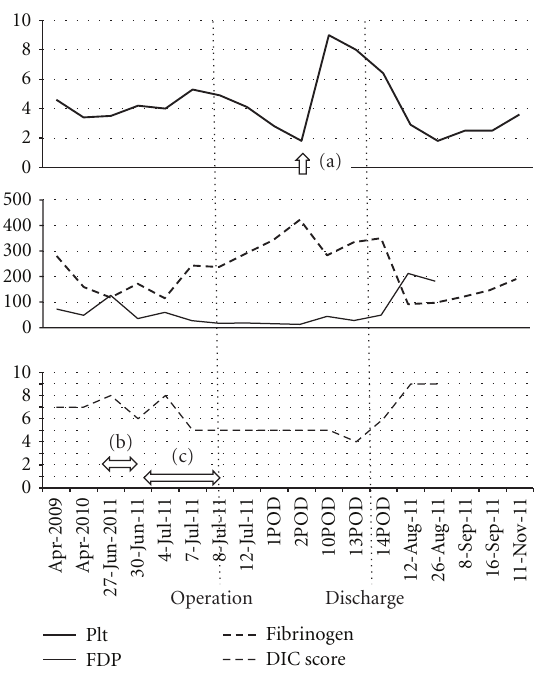
Figure 2: Changes in laboratory data (platelet count and fibrinogen and FDP levels) and DIC score. After administration of γ -globulin on POD 3 (a), PTR was alleviated and the platelet count increased. Before the operation, we used UFH for the treatment of DIC but in vain (b). Subsequent use of FUT and rhsTM for 1 week (c) successfully improved the DIC score but did not alleviate the